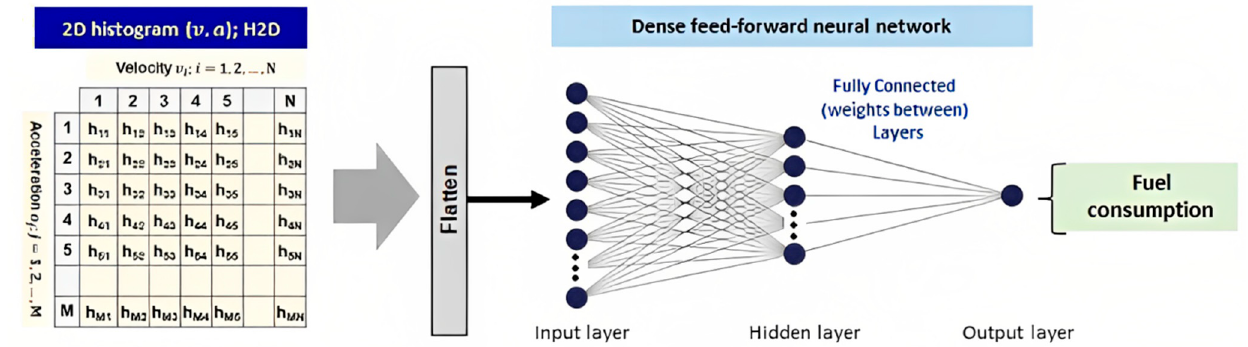
Figure 4. Proposed neural network for fuel consumption prediction, based on driving cycle-related 2D [32].